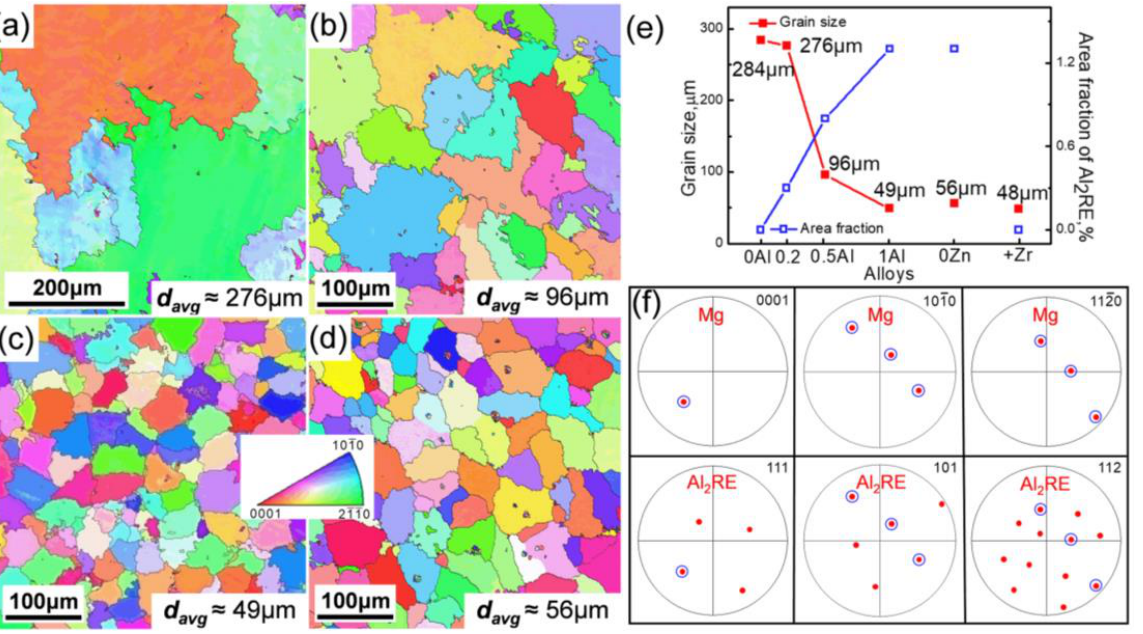
Figure 4. EBSD IPF maps the as-cast alloys: ( a – c ) 0.5Zn-xAl (x = 0.2, 0.5, and 1.0); ( d ) 0Zn-1.0Al, ( e ) the line chart about average grain size and Al 2 RE phase area fraction obtained from these six alloys, ( f ) pole figures from both a polygonal particle at a grain center and its surrounding α -Mg.